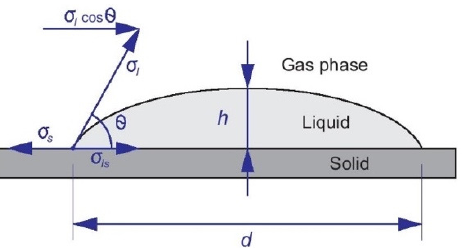
Figure 1. A drop on a surface with an indication of the contact angle and surface tension for three media, respectively (according to Kinlokh [25]).